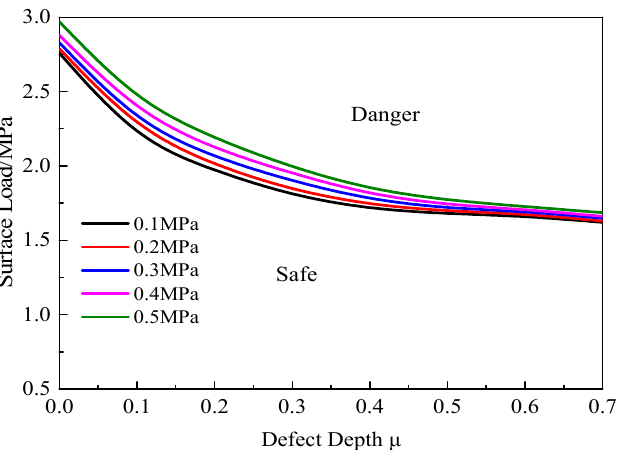
Figure 24. Defect depth-critical surface load curves under various internal pressure loads (0–30°).